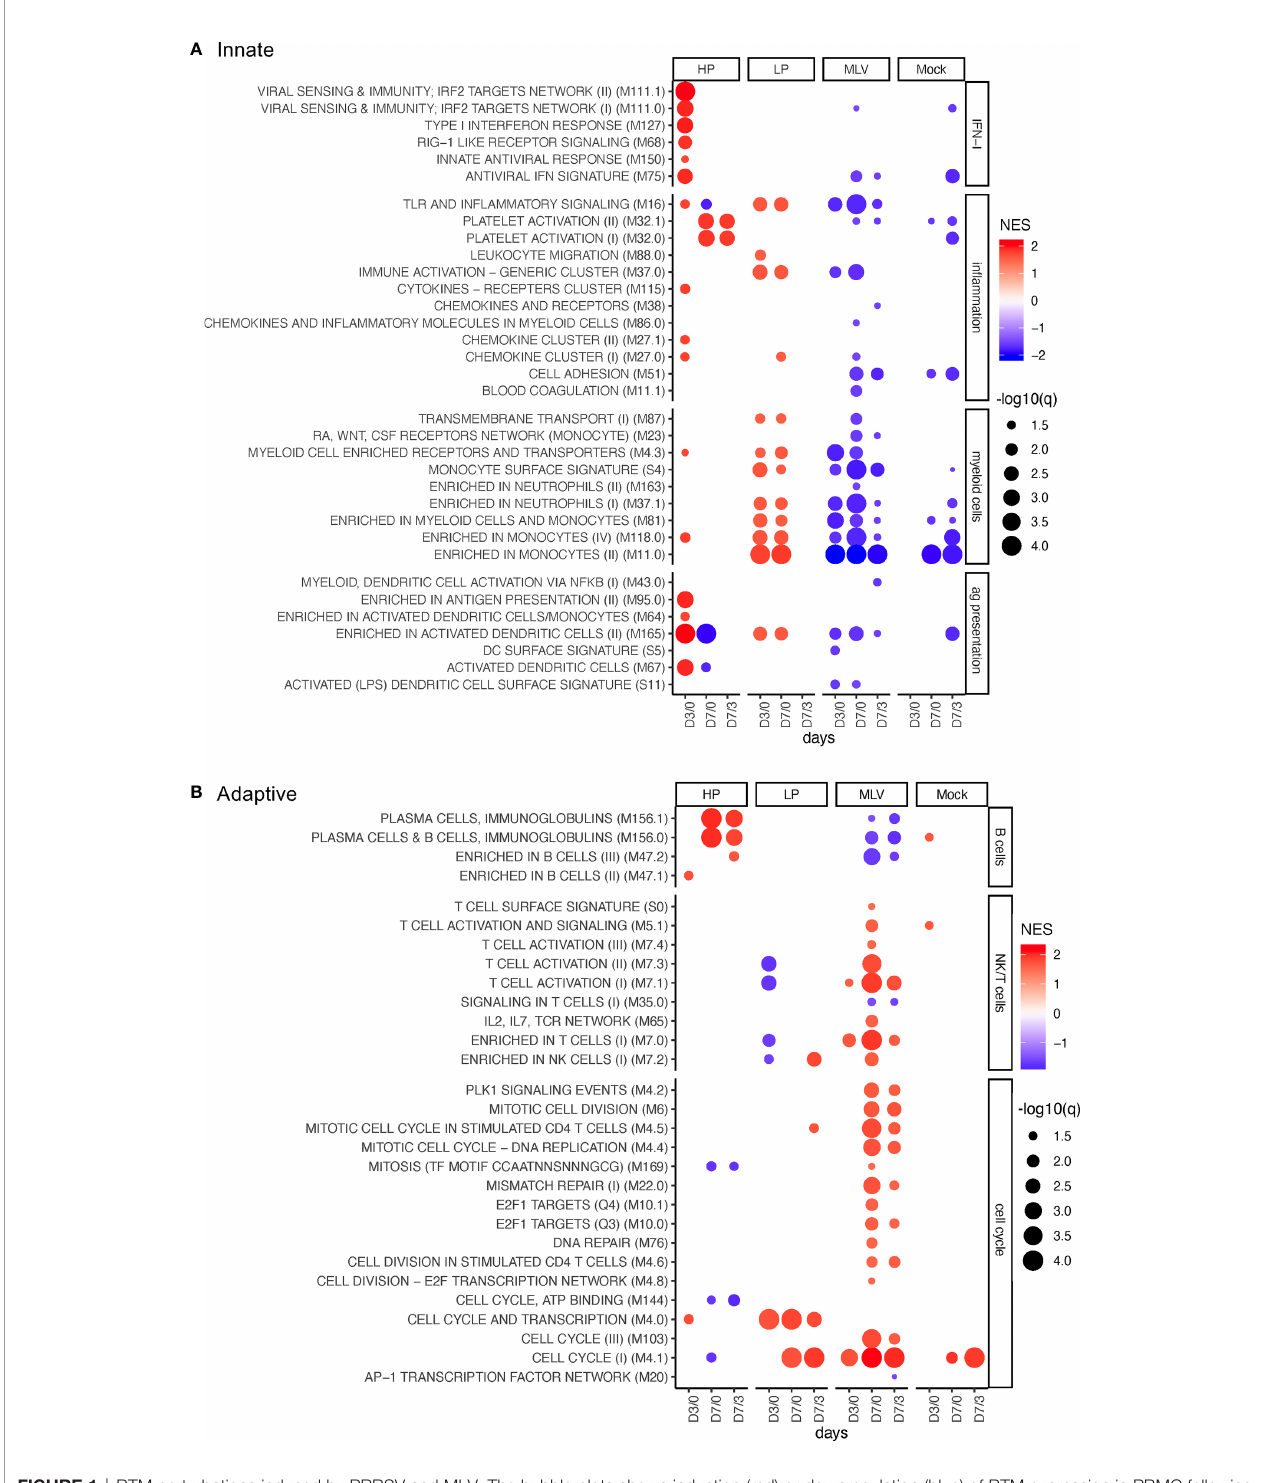
FIGURE 1 | BTM perturbations induced by PRRSV and MLV. The bubble plots shows induction (red) or downregulation (blue) of BTM expression in PBMC following infection with HP, LP PRRSV2, MLV, or MOCK injection. The changes in BTM activity were determined for D0 to D3 (D3/0), from D0 to D7 (D7/0), and from D3 to D7 (D7/3). Treatments are de fi ned in the x-axis. (A, B) show innate and adaptive BTM, respectively. On the left side of the heat map, the BTM families de fi ned previously (11) are indicated. Circle sizes represent q-values, and color intensity represents the normalized enrichment scores (NES). A cutoff of an FDR of q<0.05 was